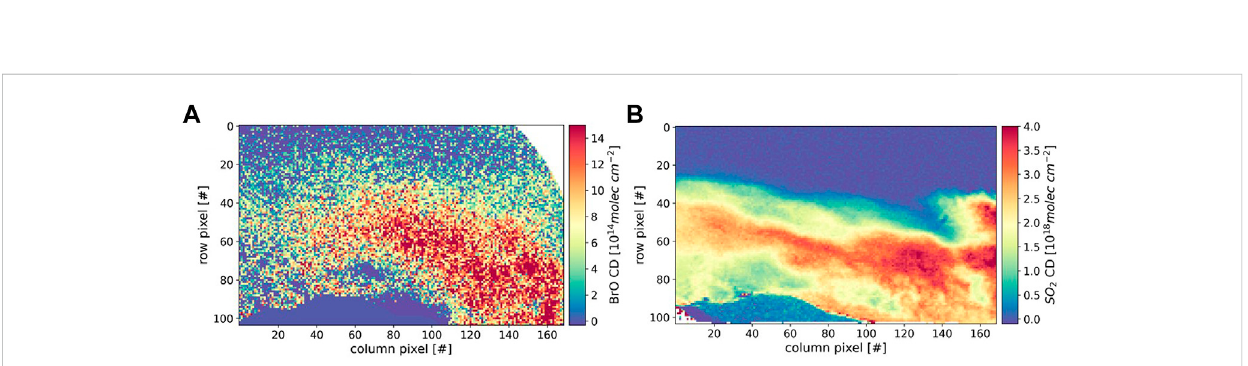
FIGURE 10 Cutout of BrO and SO 2 images acquired at the 24th of July with the IFPICS instruments. The plume originating from the Bocca Nuova crater moves from right to left through the image above the south eastern crater of Mt Etna. Panel (A) shows the BrO camera image and panel (B) the SO 2 camera image. The images are cutout to show the same FOV and scaled to have a similar temporal (10 s) and spatial resolution (104 × 169 pixels).